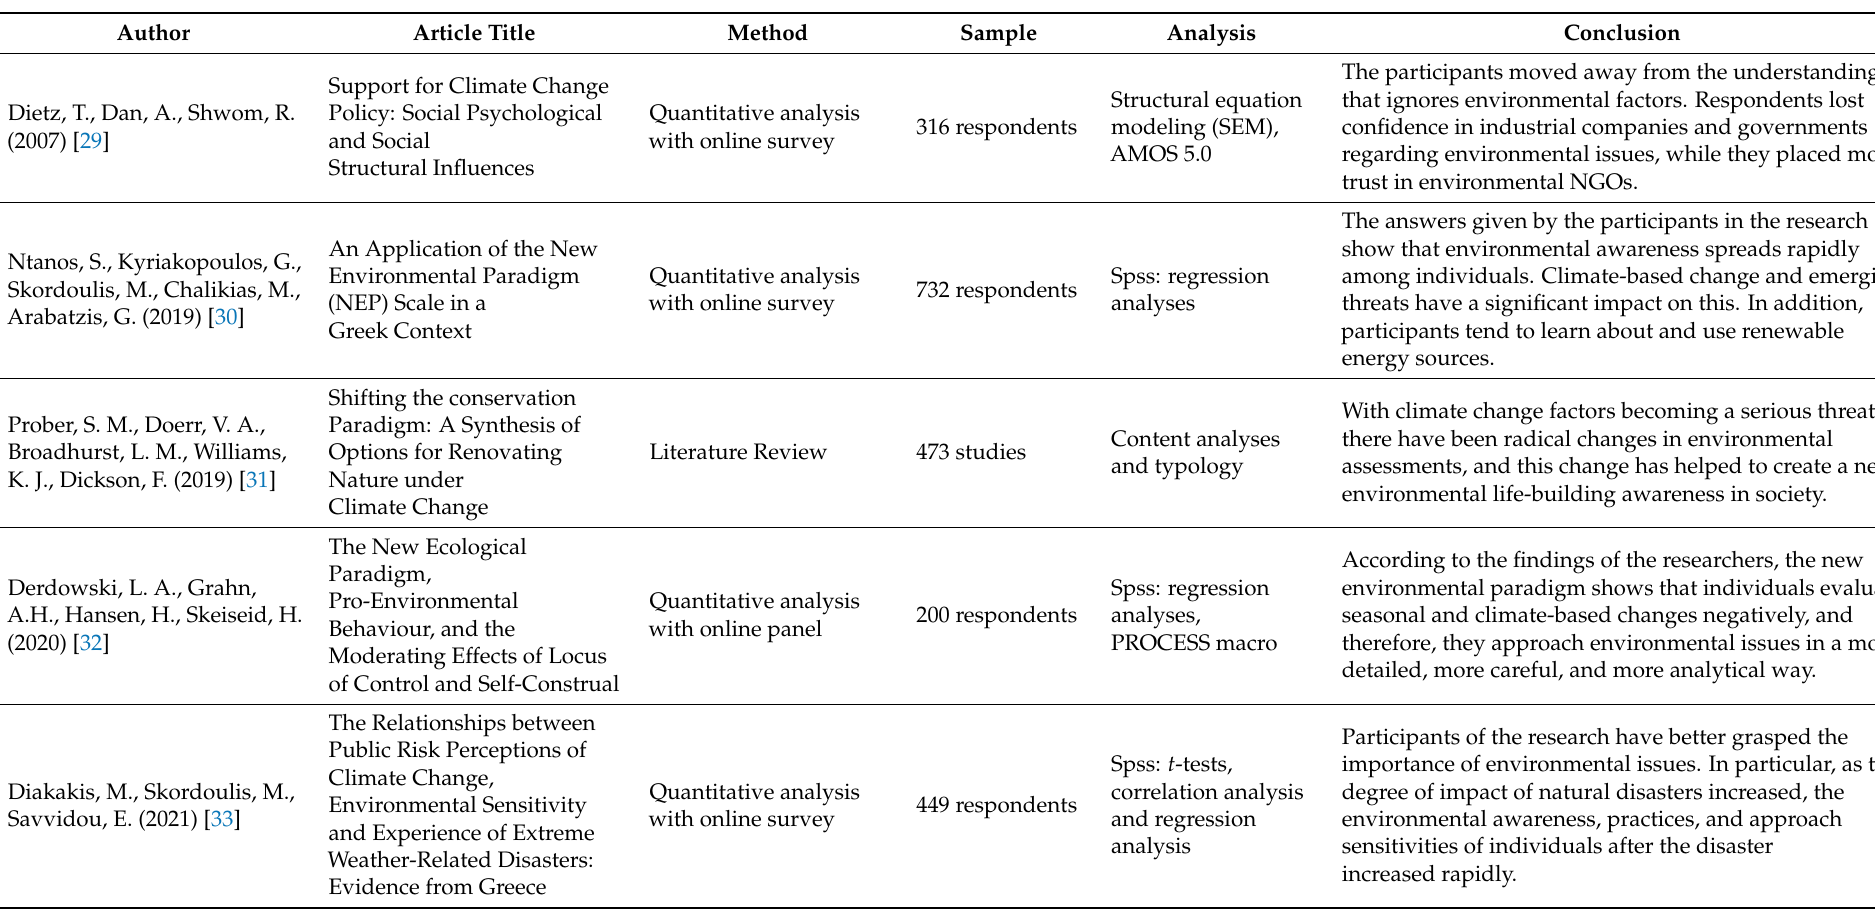
Table 1. Summary and comparison of related studies in the field of climate change and